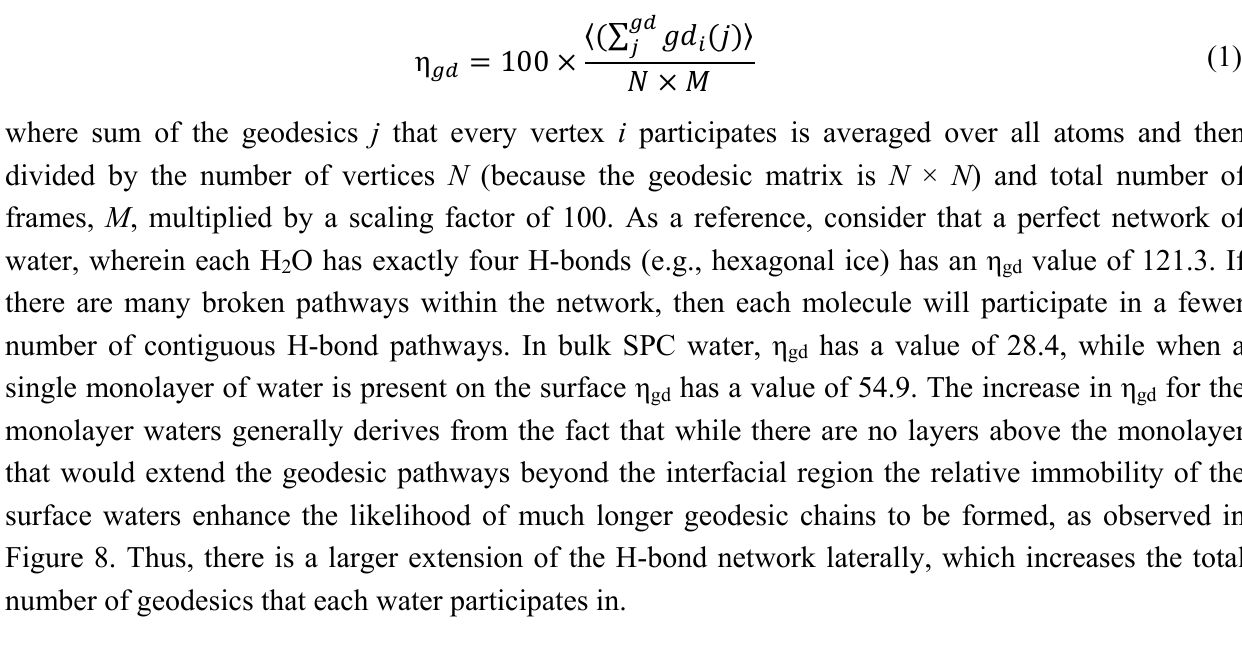
Figure 7. Dipole angle oscillations on the quartz surface with the monolayer